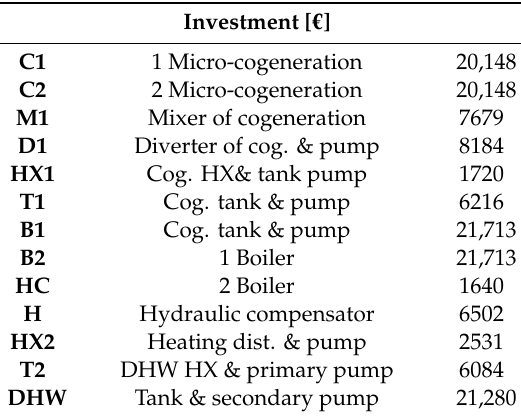
Table 1. Equipment acquisition costs.